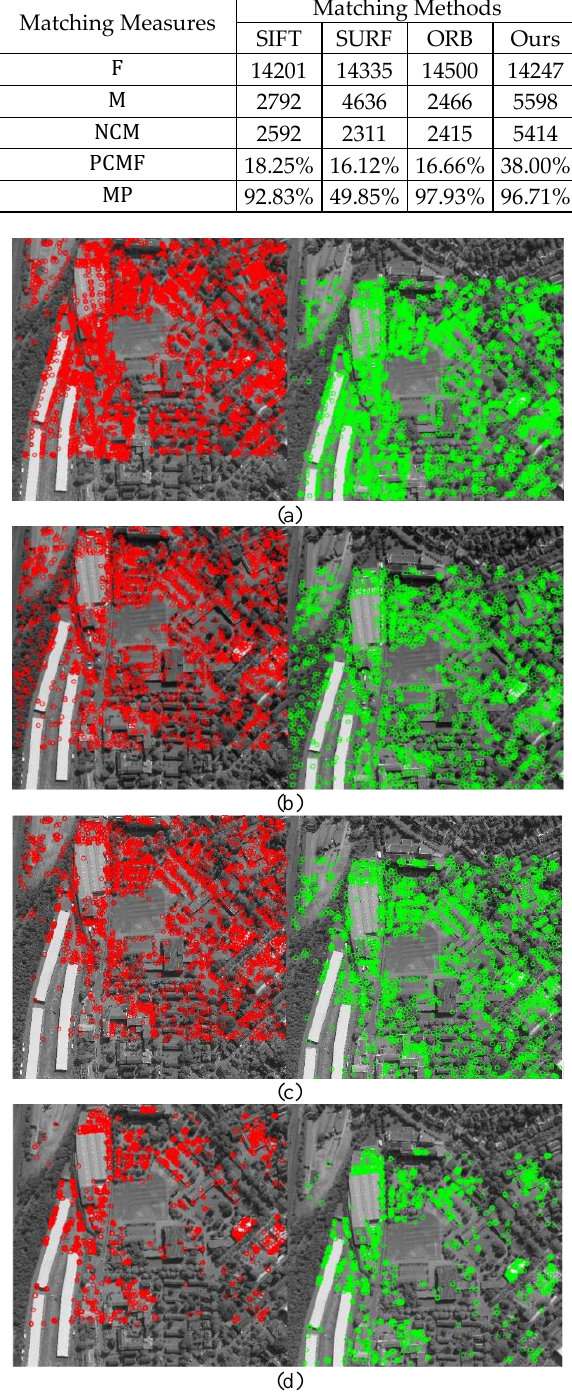
Figure 9. Feature correspondence for the third image pair (airborne- Nadir view). Results obtained using (a) the proposed